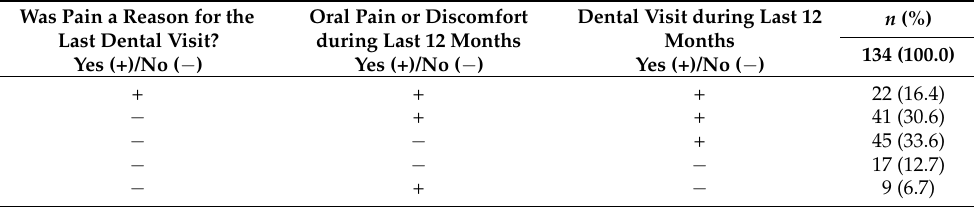
Table 6. Pain as a reason of dental visits.